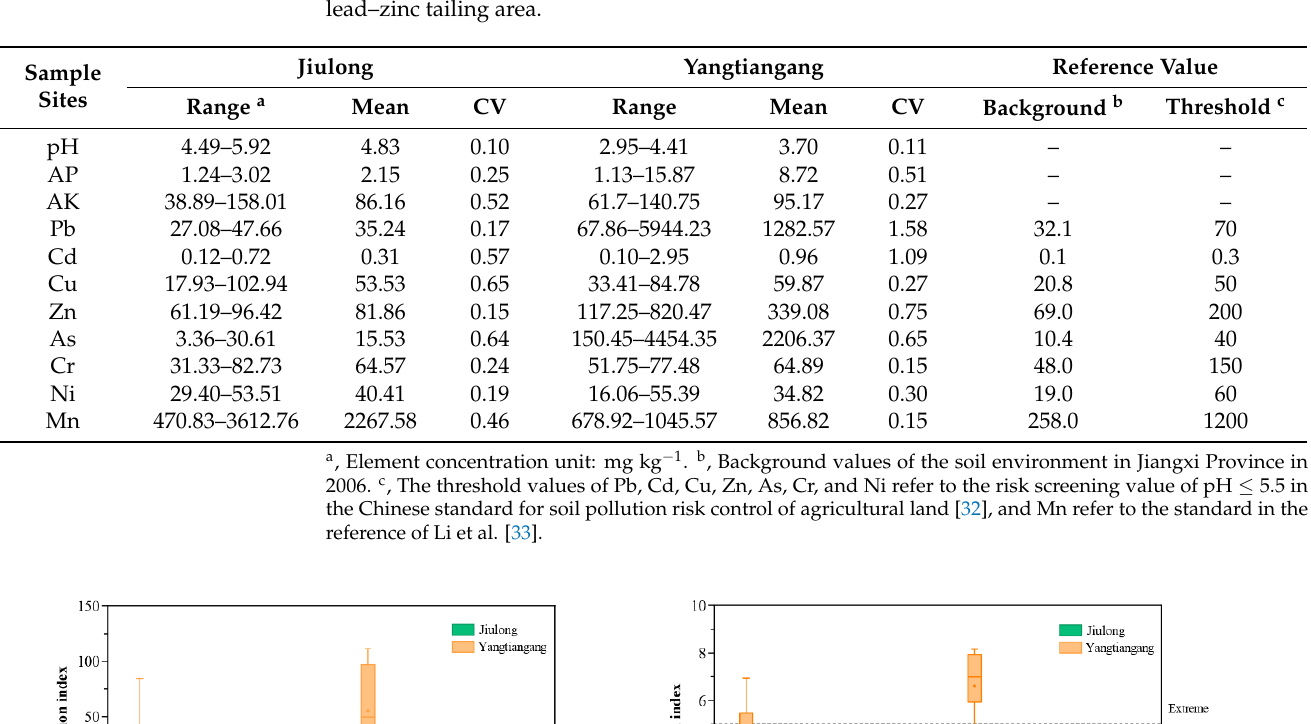
Table 2. Soil characteristics and reference values in the Jiulong iron tailing area and Yangtiangang lead – zinc tailing area.